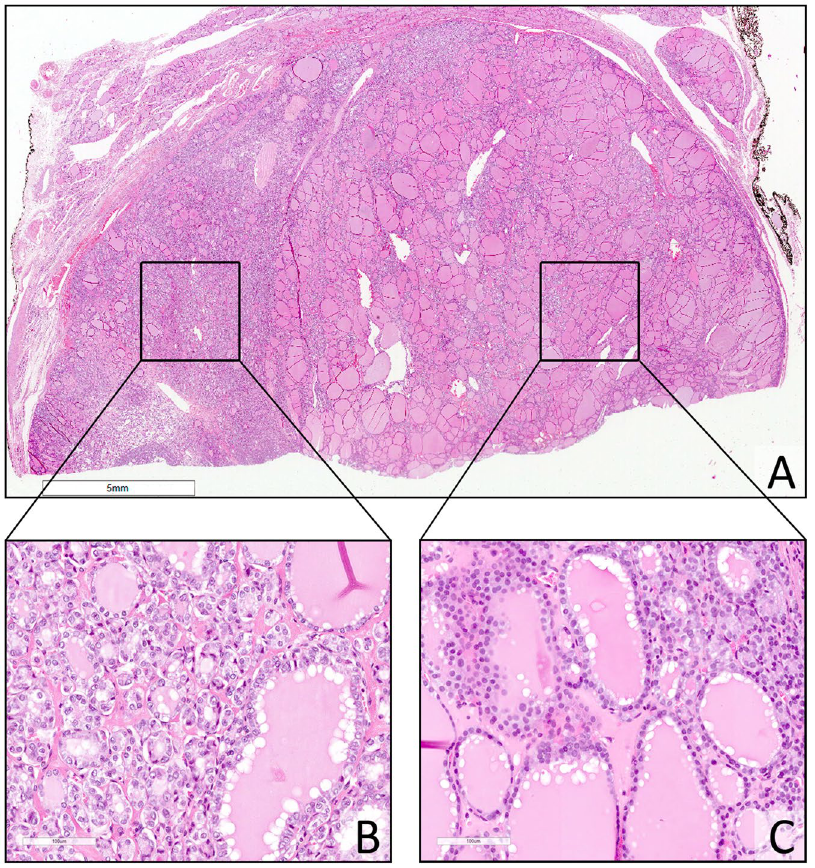
Figure 2. ( A ) Sprinkling Noninvasive follicular thyroid neoplasm with papillary-like nuclear features (NIFTP). (H&E, 4x). ( B , C ) Different cells populations Noninvasive follicular thyroid neoplasm with papillary-like nuclear features (NIFTP) showing the sprinkling; on the left, papillary thyroid carcinoma-like (PTC-like) features and, on the right, follicles with dark, hyperplastic-like nuclei. (H&E, 20x)